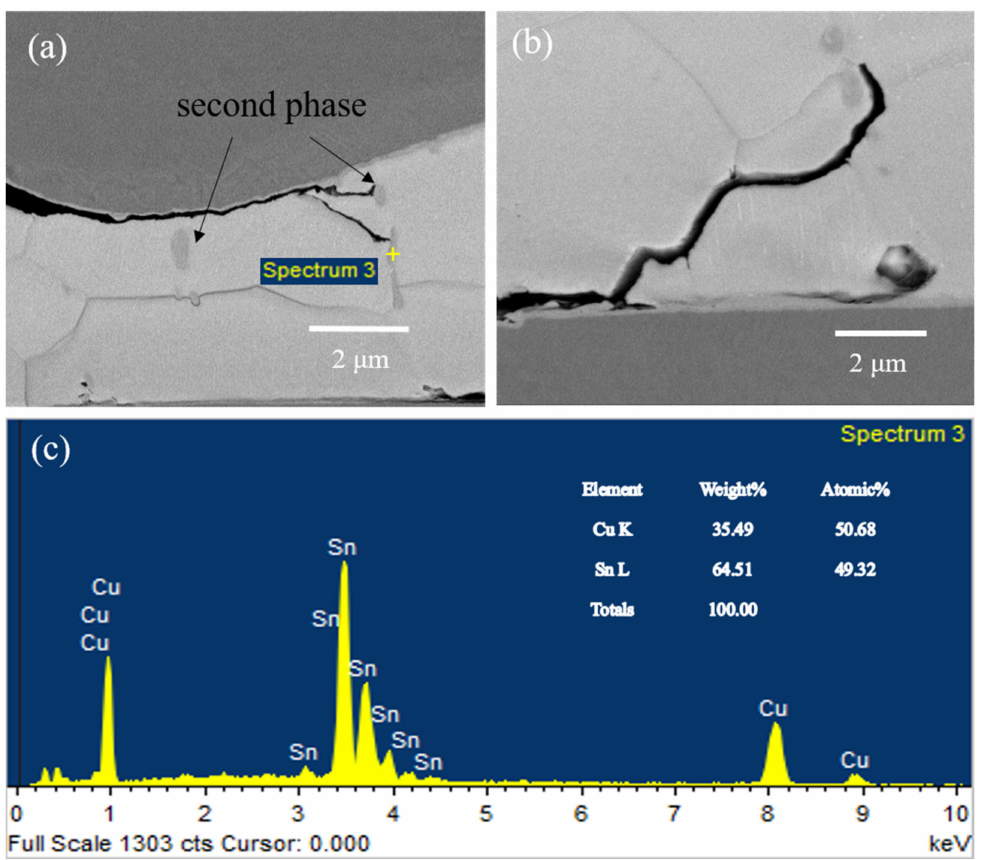
Figure 16. The second phase was identified as Cu 6 Sn 5 IMC. IMC particles can be seen clearly in the junction of Sn grains, which is formed by Cu atoms diffusing along the grain boundary and precipitating in the junction in the form of Cu 6 Sn 5 during the solidification process. These Cu 6 Sn 5 particles play a significant role in the arresting and deflection of cracks. As can be seen in Figure 16a,b, crack tips meet the second phase and stop propagating. A higher driving force is required to either propagate around the second phase by deflection, or to continue through the second phase, the latter being less probable from an energetic point of view. Therefore, once arrested by the boundary junction, cracks would further proceed along the boundary of the IMC particle and Sn grain, while the preferred direction of all possible ones is related to the deflection angle, finally forming fracture patterns that differ from one sample to another in shape. The Ag 3 Sn IMC grains were believed to not have a significant impact on the crack propagation path since they were present in the form of a primary eutectic component located inside each Sn grain [17,18]. It electrical load, the fatigue crack preferred an intergranular propagation path [19,20], in which case, the reconstructed grain structure and recrystallization might contribute to the weakening of grain boundary strength. This inclination seems to apply well to the highly dynamic and purely mechanical drop impact scenario. We can also reasonably suspect that if the interfacial IMC grows to a certain thickness that leaves visible voids due to the volume shrinkage effect, the bonding interface will be much weakened in that the crack will only propagate along the voided interface.